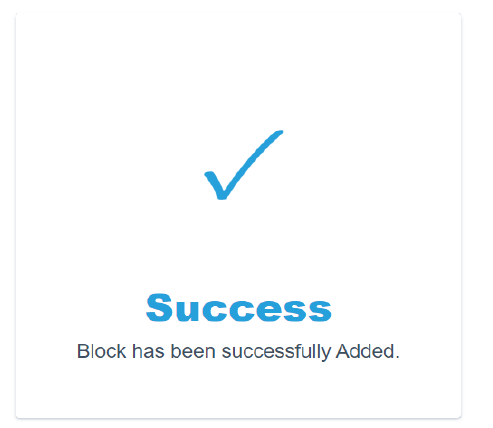
Figure 12: Message after addition of block to blockchain. Figure 10: Manufacturer adding the details of the product.